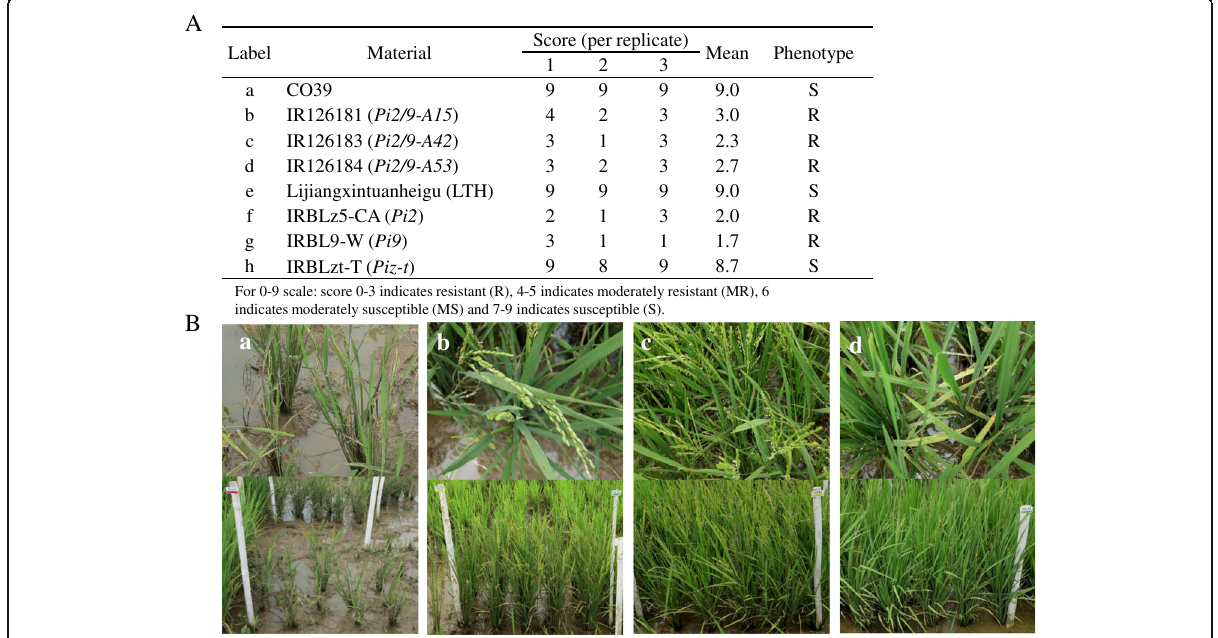
Fig. 2 Field assessment of the introgression lines IR126181 ( Pi2/9-A15 ), IR126183 ( Pi2/9-A42 ), IR126184 ( Pi2/9-A53 ), IRBLz5-CA ( Pi2 ), IRBL9-W ( Pi9 ) and IRBLzt-T ( Piz-t ) together with the susceptible control CO39 and LTH. a Scoring of the introgression lines in the field with three replicates for each line. b Photograph of the disease reaction of introgression lines of b IR126181, c IR126183, d IR126184 and a susceptible control CO39